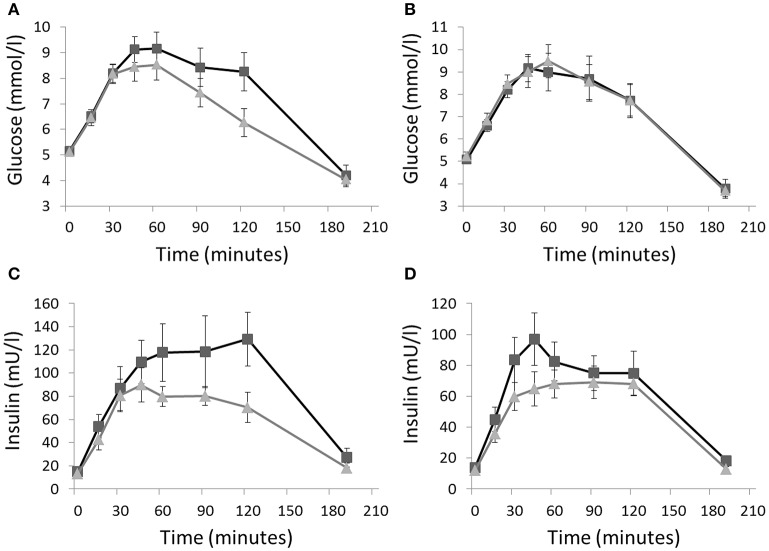
Glucose and insulin responses to an oral glucose tolerance test on the morning after the Sit (■) and SitLess (▴) regimens for respectively women (A,C) and men (B,D). iAUC for glucose in women was lower after SitLess vs. Sit (p = 0.006), but not in men (p = 0.266). AUC for insulin was significantly lower after SitLess vs. Sit in men and women (p = 0.006). Means and standard error bars are presented.